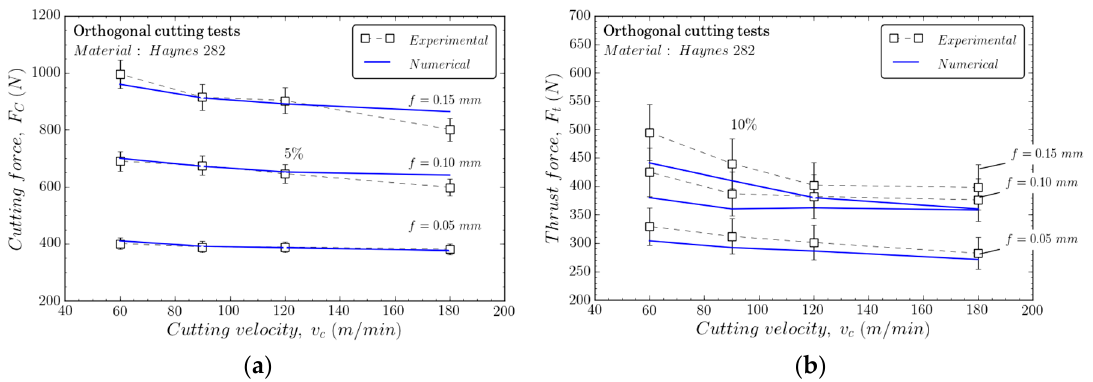
Figure 13. Numerical ( a ) and experimental ( b ) cutting forces for Haynes 282.